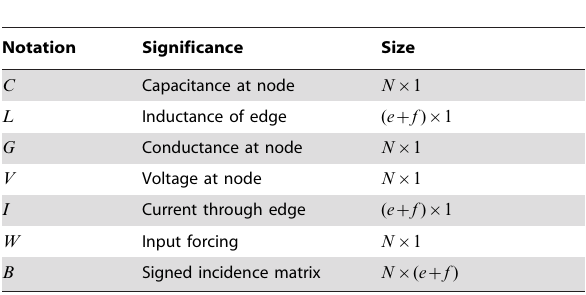
Table 2. Summary of the notation used in the paper.